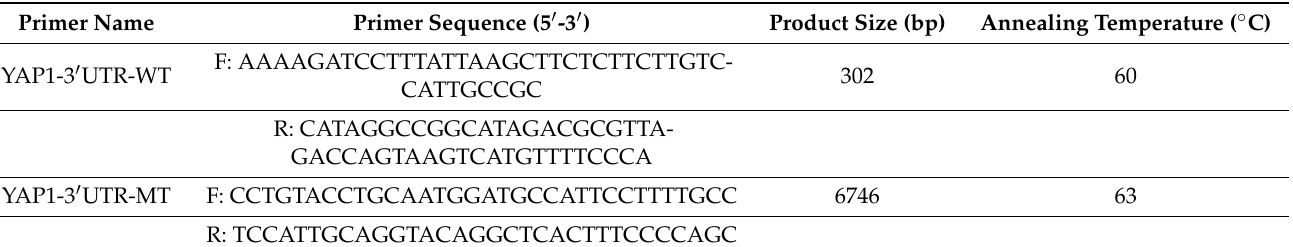
Table 4. Primers of construction of related